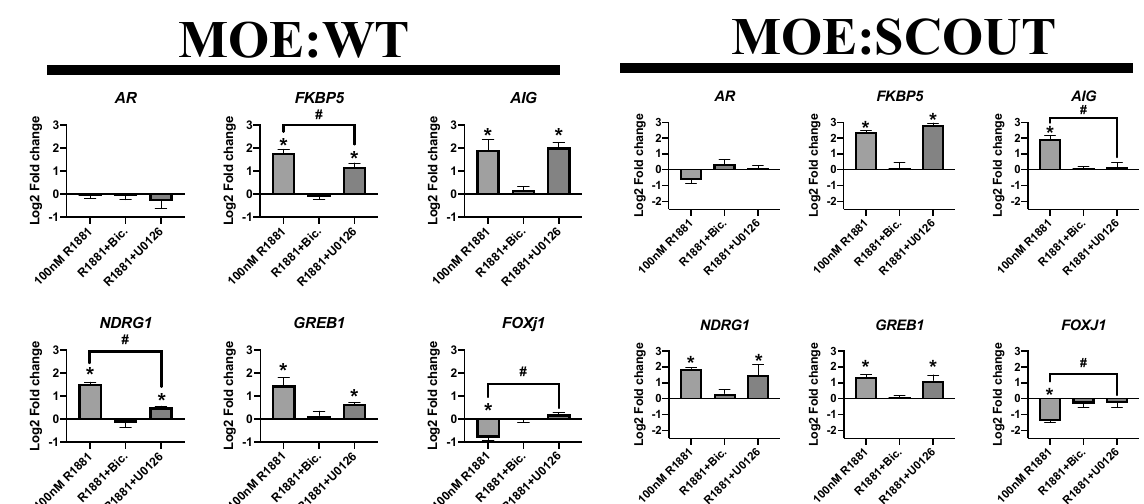
Figure 5. U0126 blocks transcription of some, but not all, putative AR target genes in fallopian tube cells. qPCR analysis of select androgen responsive genes shown as Log 2 fold change compared to DMSO control. ( n ≥ 3, one-way ANOVA followed by a Dunnett’s post-hoc; * p < 0.05; Additionally, unpaired t-test comparing cells treated with 100 nM R1881 to 100 nM R1881 + 1 µ M U0126 was performed; # p < 0.05).